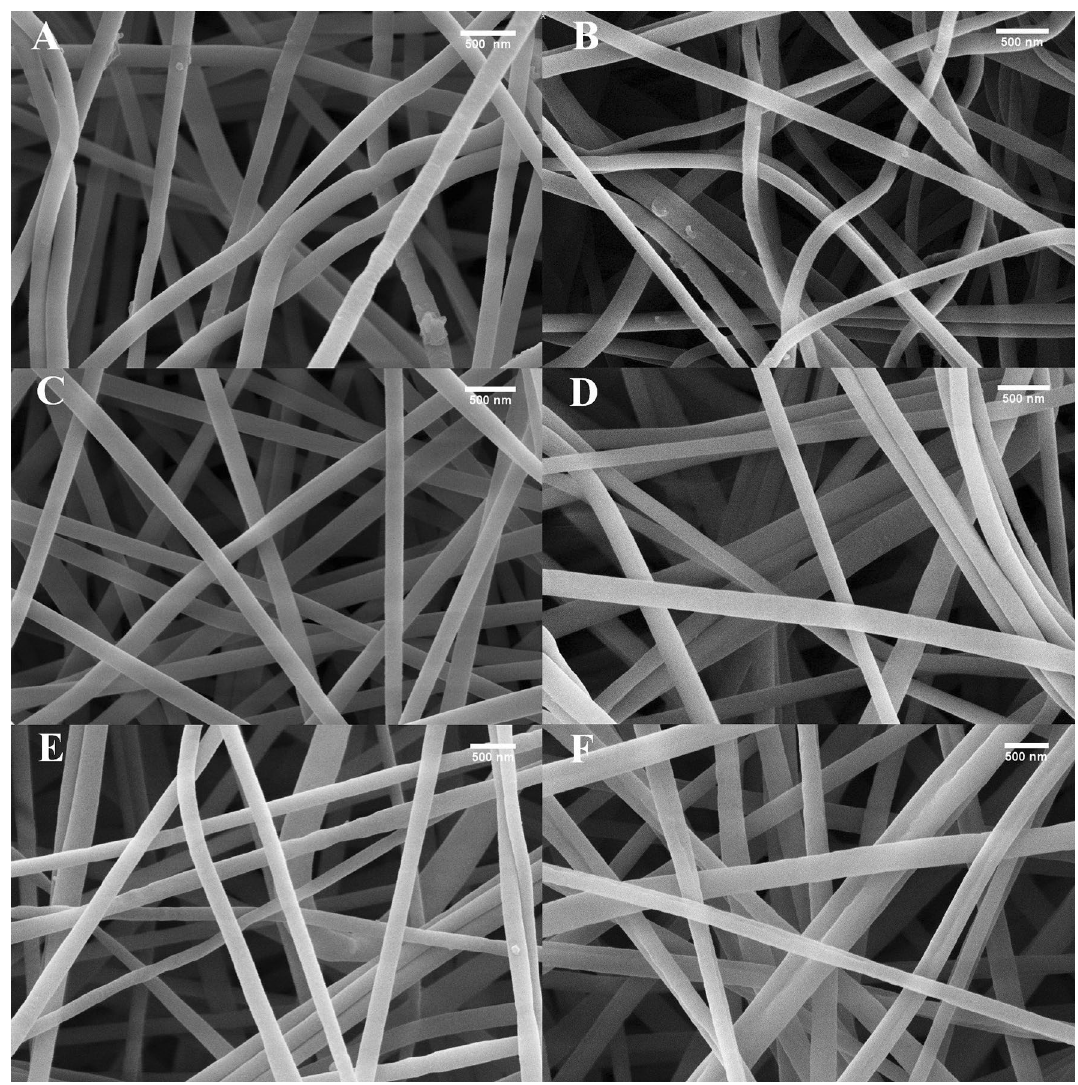
Figure 6. SEM photographs of polyaniline–polyacrylonitrile composites: ( A ) PAN–PANI A (1%), ( B ) PAN– PANI A (3%), ( C ) PAN–PANI B (1%), ( D ) PAN–PANI B (3%), ( E ) PAN–PANI C (1%), ( F ) PAN–PANI C